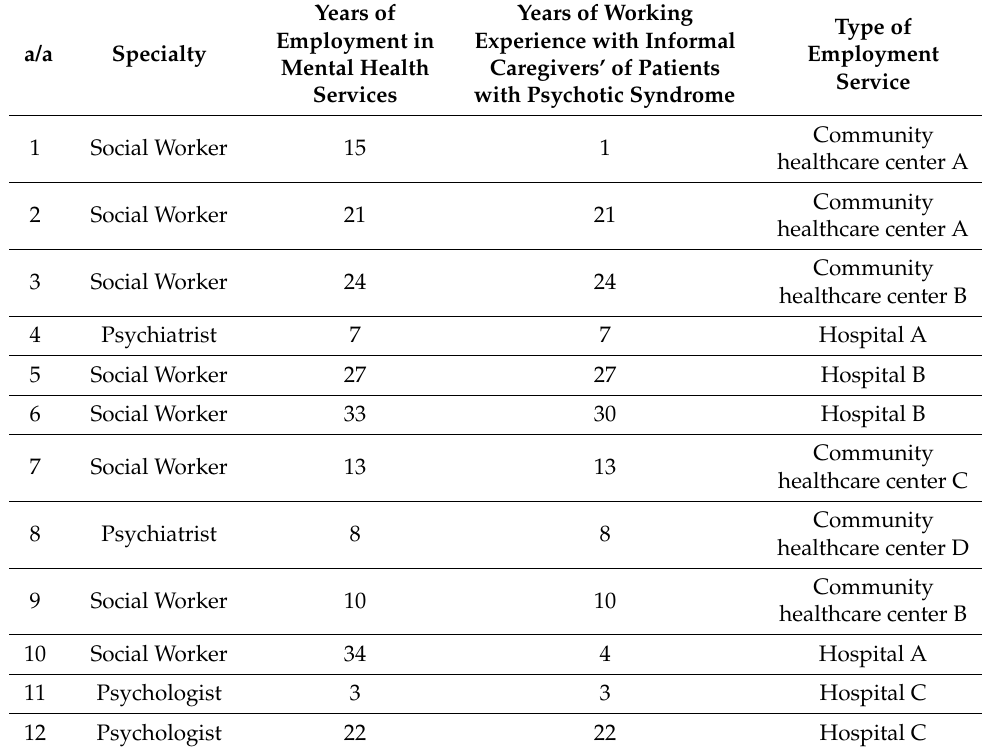
Table 1. Characteristics of the study sample.